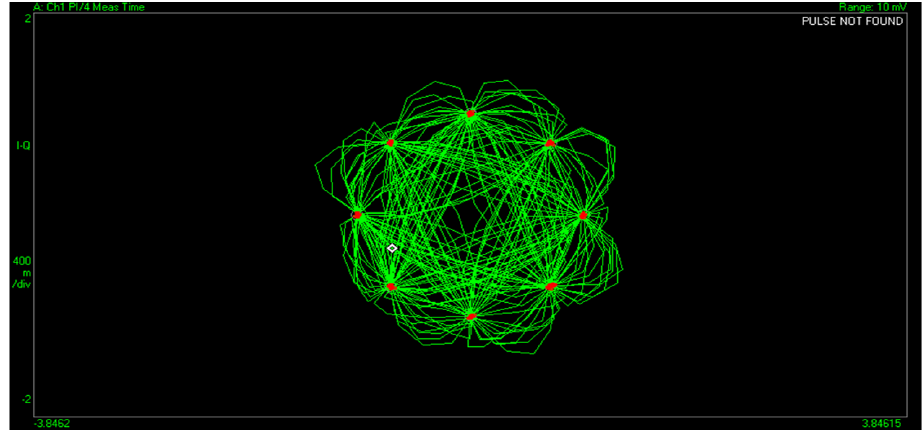
Table 2. Bit values related to phase change.